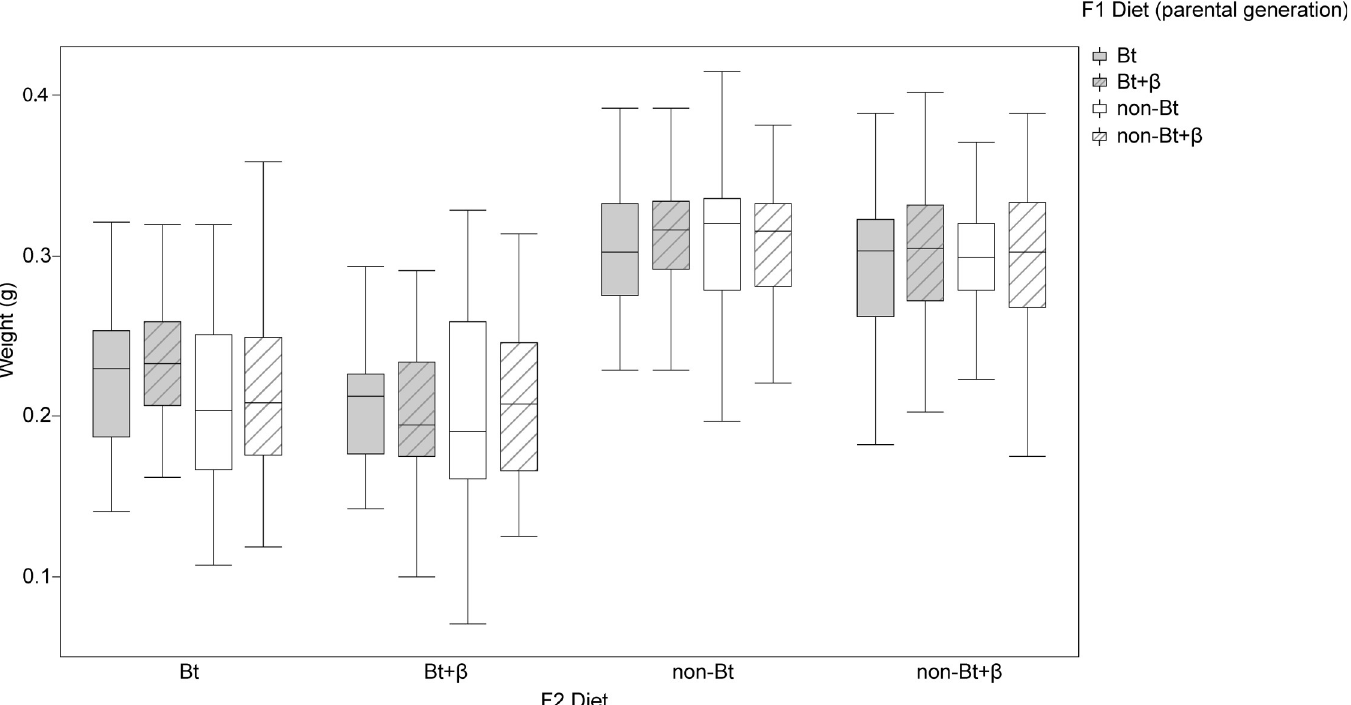
Fig 6. Weight of the Helicoverpa armigera F2 pupae. Weight of the Helicoverpa armigera pupae of F2 larvae fed Bt or non-Bt diets with or without β -carotene, from parental F1 larvae also fed 1 of the 4 experimental diets. F2 diet indicates the diet received by the experimental larvae while the F1 diet indicates the diet received by the parental larvae. Data were analyzed by two-way ANOVA ( P < 0.005), and means were compared by an LSD test.